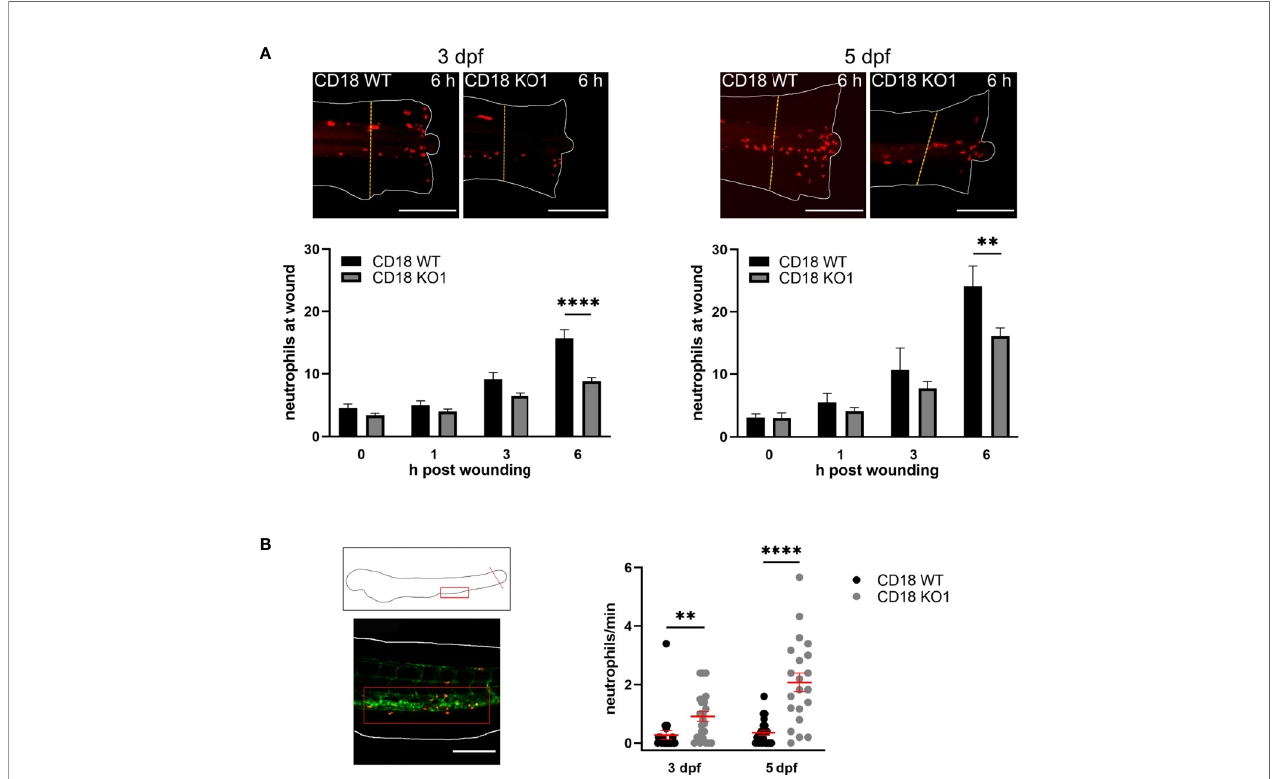
FIGURE 3 | Neutrophil traf fi cking in CD18 KO zebra fi sh. (A) Upper panel:Exemplary maximum intensity projections of neutrophil recruitment 6 hafter tail fi n transectionin CD18 WT and CD18 KO1 zebra fi shlarvae at 3 dpf (left) and 5 dpf (right). Neutrophils are depictedinred.The dashed lines indicate the 200 µm area in whichthe neutrophils were counted. Scale bars represent 200 µm. Lower panel: Quanti fi cation of neutrophil numbers at the transected tail fi nin3 dpf(left) and 5 dpf(right) CD18 WT and CD18 KO1 zebra fi sh larvae. Mean± sem of ≥ 8 individual larvae of ≥ 2 independent experiments. One-wayANOVA, p < 0.01: **, p < 0.0001: ****. (B) Schematic(upper left panel) and representative microscopic image (lower left panel) of the location of the posterior caudal vein (red box) that was imaged for quanti fi cation of circulating neutrophils. The dotted line indicates the tail fi ntransection. Scale bar represents 200 µm. Right panel: Number ofneutrophils per min detected in the circulation6 h after tail fi n transectionin CD18 WT and CD18 KO1 zebra fi sh larvae at 3 dpf and5 dpf. Mean ± sem of ≥ 21 individual larvae of 3 independent experiments. Unpairedt-test, p < 0.01: **, p < 0.0001: